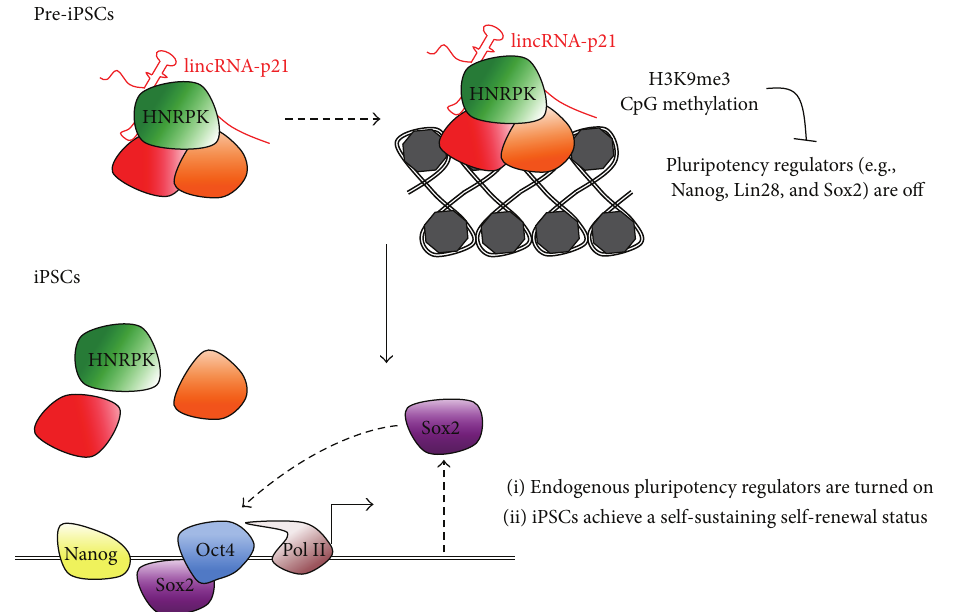
Figure 3: lincRNA-p21 regulates the transition of pre-iPSCs to iPSCs. During reprogramming, the induction of endogenous pluripotency genes is necessary to achieve a self-sustaining status in which the core regulatory factors act in a positive feedback loop on their own expression. lincRNA-p21 hinders this transition by recruiting an inhibitory complex, which deposits repressive marks such as H3K9me3 and CpG methylation on the promoters of pluripotency regulators